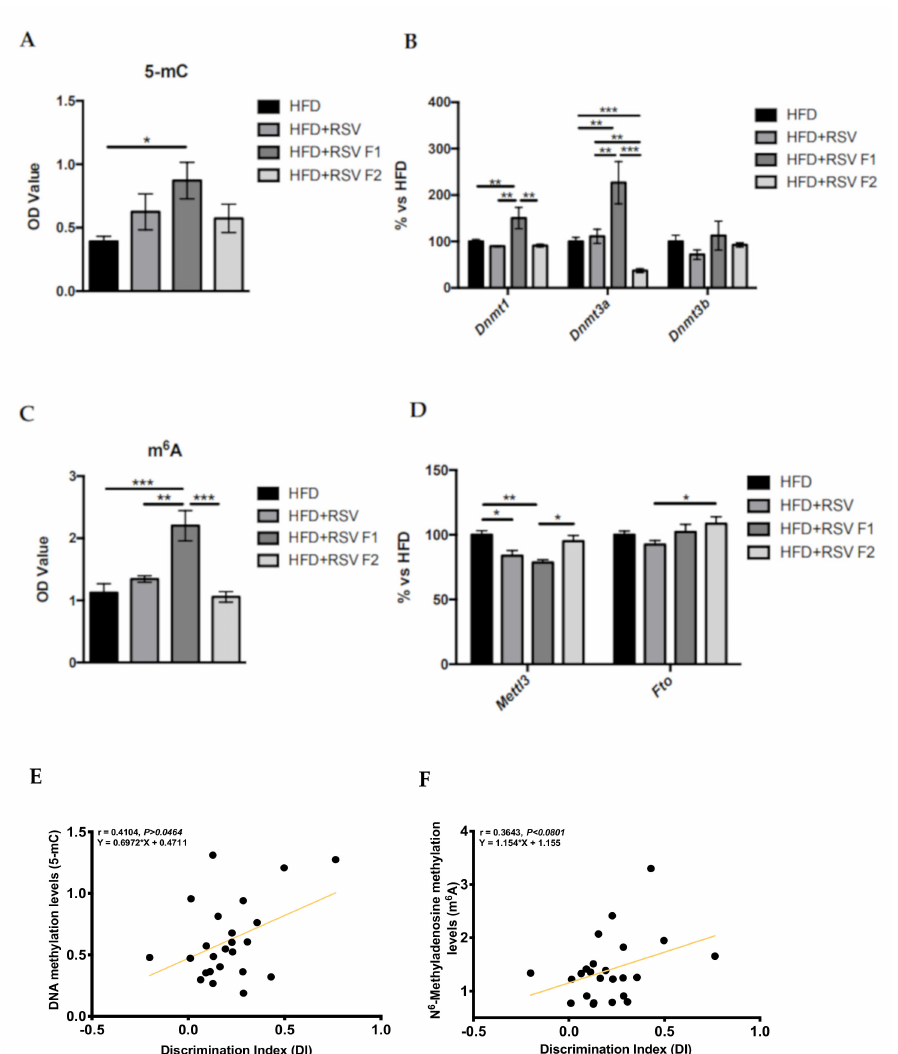
Figure 3. 5-mC levels in the hippocampus of SAMP8 mice at 6 months of age for all groups ( A ). Relative gene expression of Dnmt1, Dnmt3a, and Dnmt3b ( B ). m 6 A levels from the hippocampus of SAMP8 mice at 6 months of age for all groups ( C ). Relative gene expression for Mettl3 and Fto ( D ). Correlations between 5-mC levels ( E ), m 6 A ( F ) with discrimination index (DI). Gene expression levels were measured by real-time PCR from hippocampal tissue. Gene expression data from each RSV group were compared to the HFD group (set at 100%); n = 16-24 (HFD n = 4-6, HFD + RSV n = 4-6, HFD + RSV F1 n = 4-6, HFD + RSV F2 n = 4–6; for each group, females n = 3–4, males n = 3–4). Statistics: * p < 0.05; ** p < 0.01; *** p < 0.001. Person correlations were performed between the behavioral test and molecular parameters for each group ( n = 6). R and p-values were indicated on graphs. The level of significance was p <